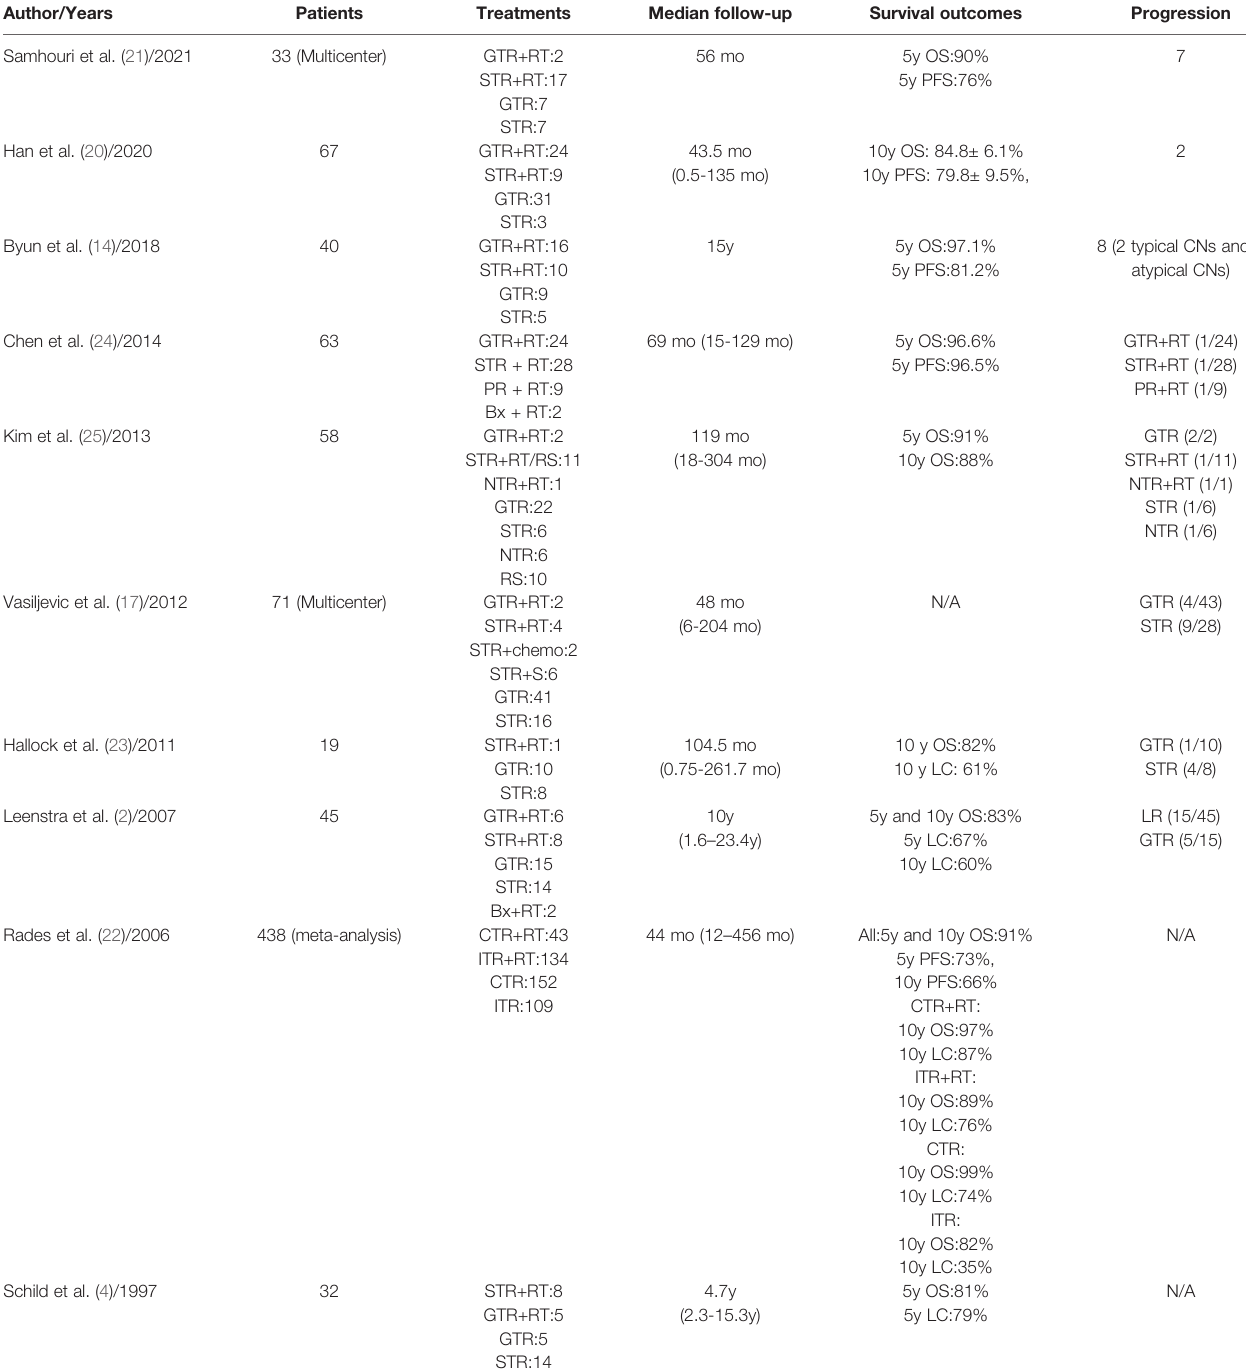
TABLE 4 | Survival outcomes of some large retrospective studies on central